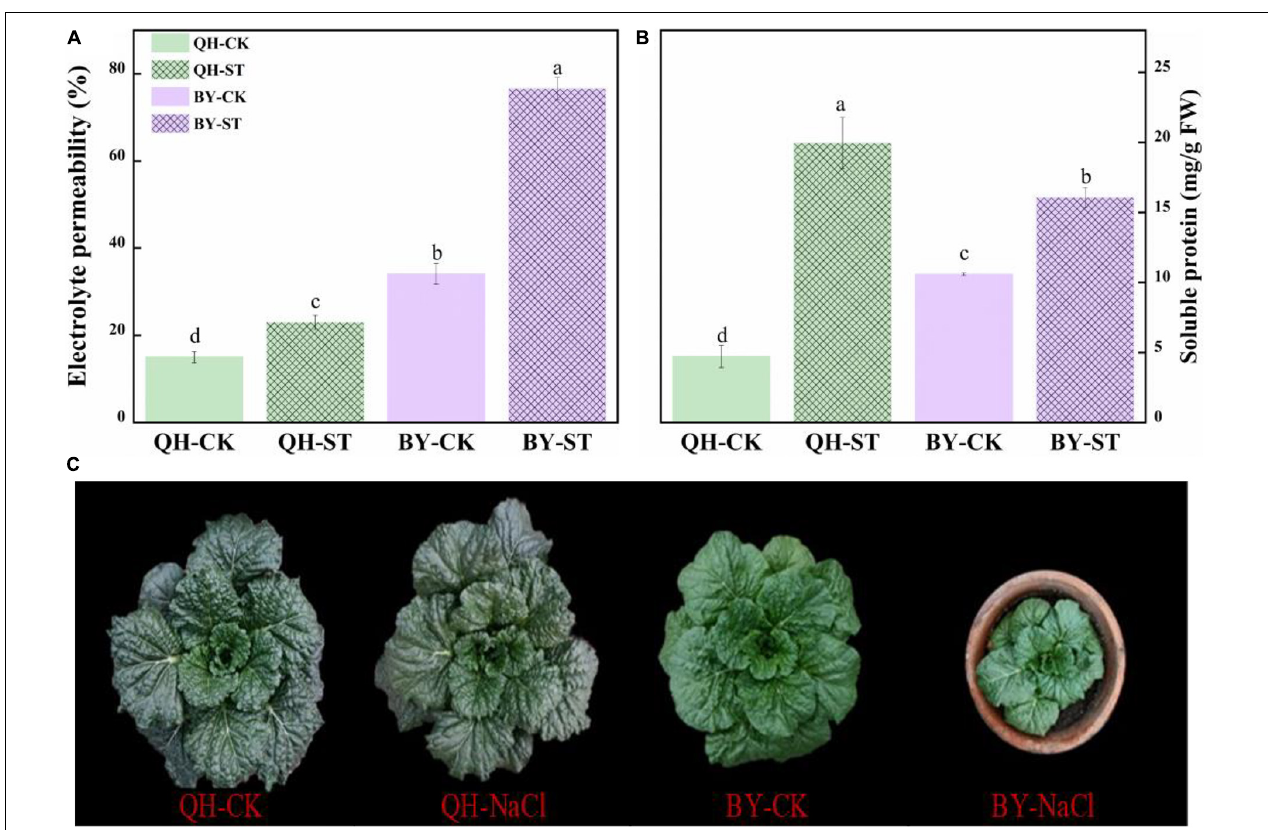
FIGURE 3 | Effect of salt on electrolyte permeability, soluble protein and the growth of Qinghua45 (QH) and Biyuchunhua (BY). (A) Electrolyte permeability. (B) Soluble protein. (C) Growth condition of the whole plant after treatment with NaCl for 40 days. QH-CK: Qinghua45 treated with 0 mmol L - 1 NaCl, QH-ST: Qinghua45 treated with 100 mmol L - 1 NaCl, and so on. All data were determined 20 days after NaCl treatment. The data are the mean ± SD, and the different letters (a–d) indicate a significant difference at P < 0.05 according to Duncan’s